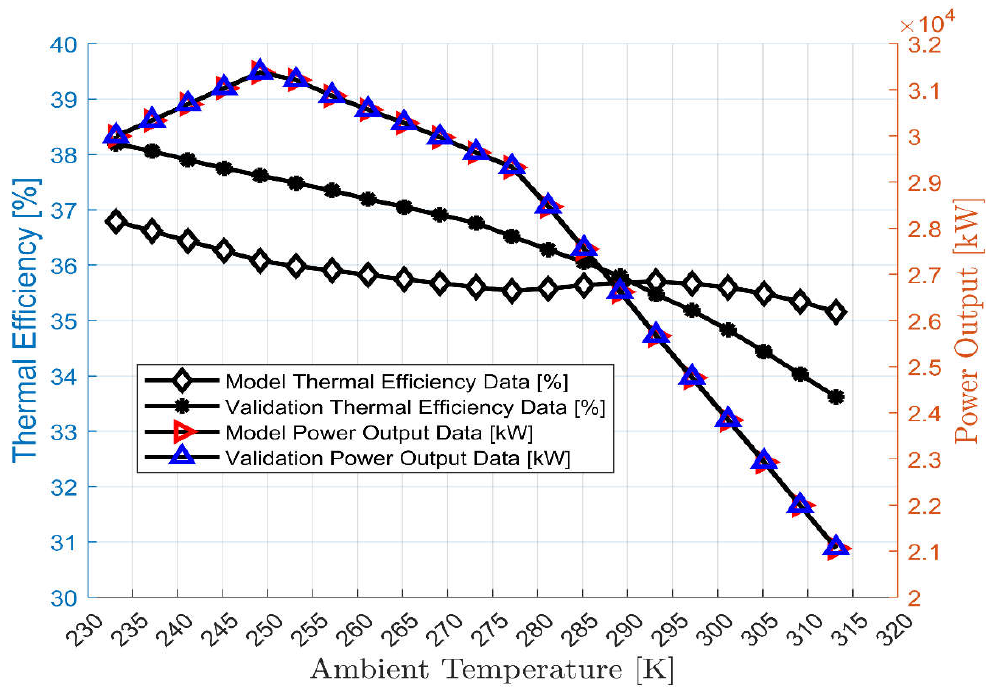
Figure 4. RB211 − 24G VIGV’s schedule (N 1 /√T 0 ).